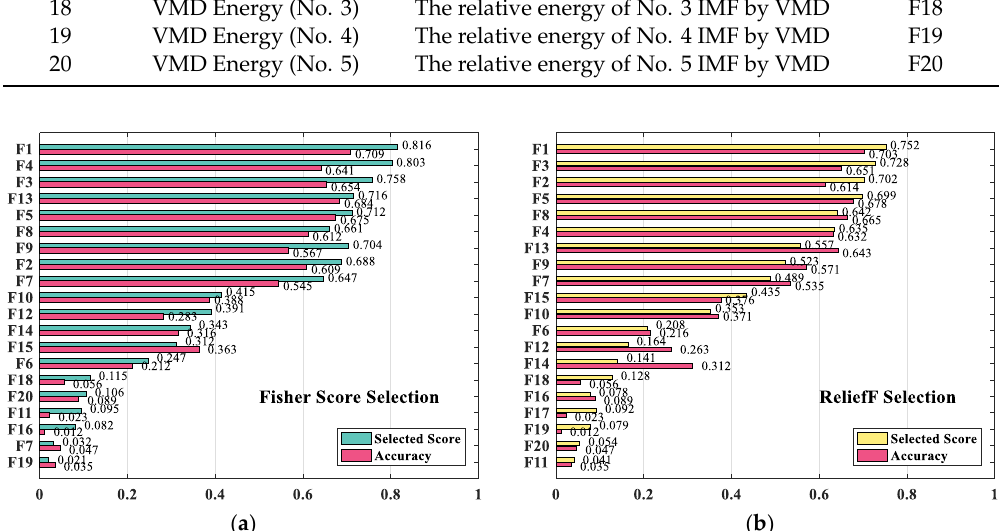
Figure 1. The correlation between the feature and classification accuracy according to the Fisher score and ReliefF algorithm. ( a ) correlation results in Fisher score; ( b ) correlation results in ReliefF.